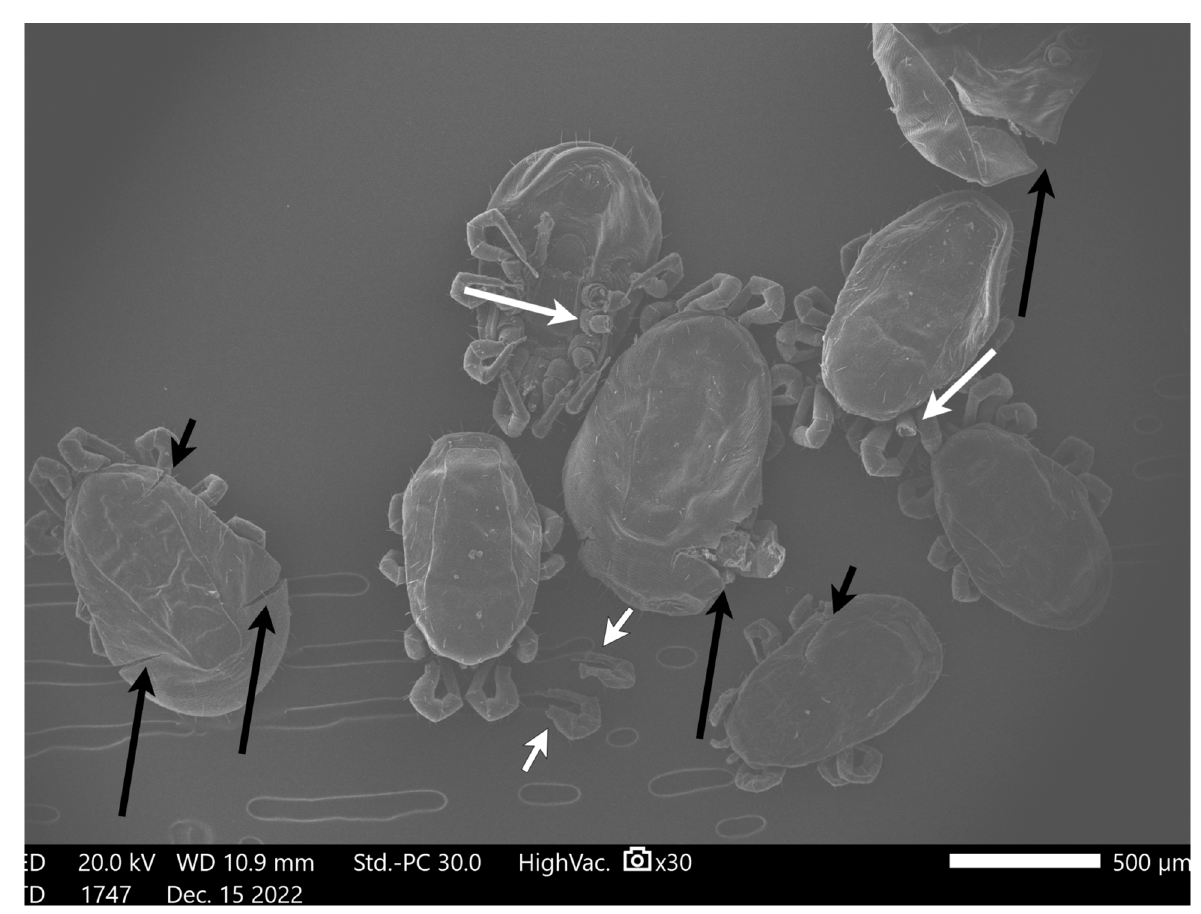
Figure 6. Micrograph of Dermanyssus gallinae after bioassays with AgNPs at 80 ppm for 1 day. There are numerous visible leg detachments (white arrows) and considerable cracks throughout their exoskeleton (black arrows).